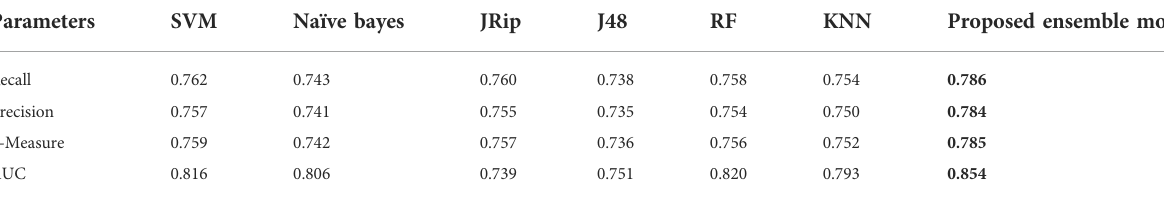
The bold values show the results for Proposed